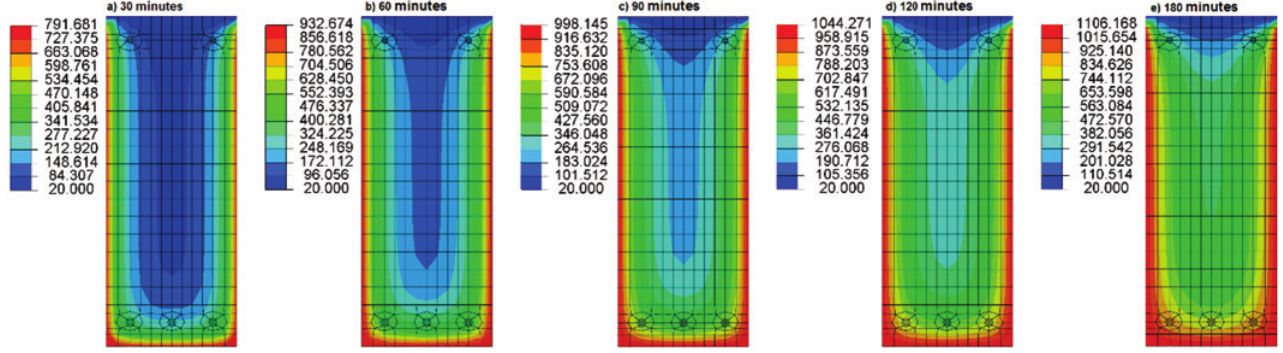
Figure 4 Isotherm B1-II for ratings of (a) 30, (b) 60, (c) 90, (d) 120, and (e) 180 minutes